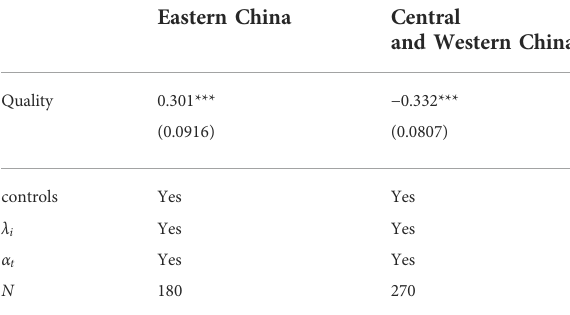
TABLE 4 Regional